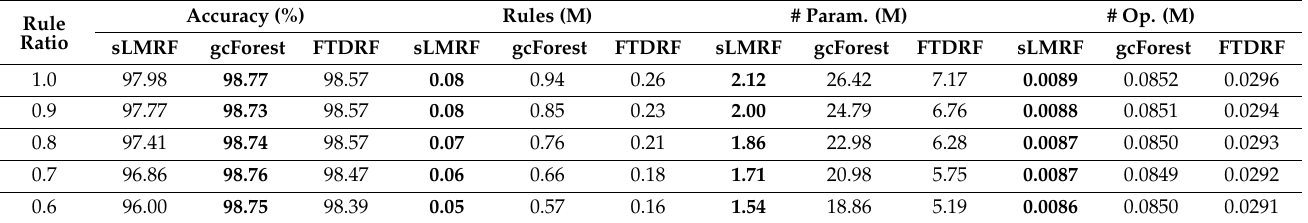
Table 3. Comparison of accuracy, number of rules, number of parameters (#Param.), and number of operations (#Op.) between DRF models according to the rule ratios using the MNIST dataset. The rule ratio 1.0 of sLMRF is the same as that of LMRF.